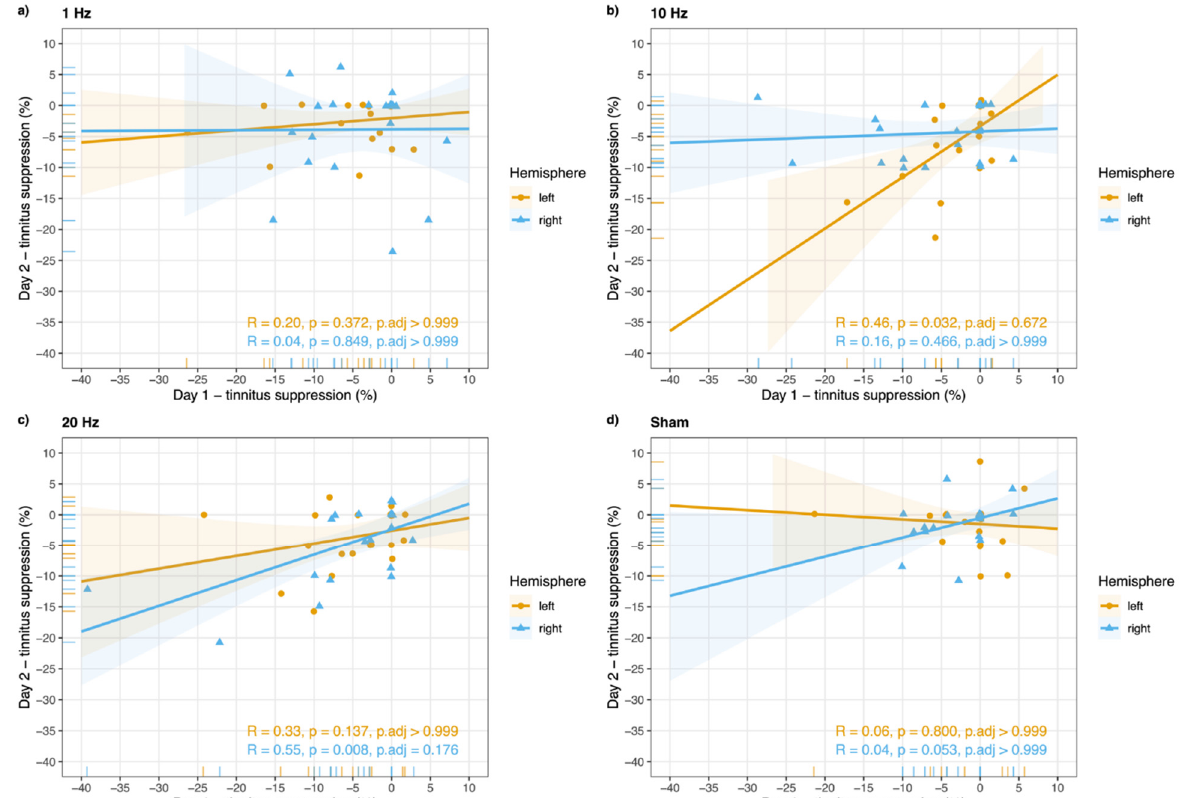
Figure 2. Reliability of TMS-induced changes in tinnitus loudness. Spearman correlations of rated tinnitus suppression (%) per rTMS protocol (1 Hz ( a ), 10 Hz ( b ), 20 Hz ( c ), sham ( d )) between the first and the second test session days are illustrated in Figure 2. Colored ribbons represent confidence intervals (95%). Reliable changes were observed for a ( b ) 10 Hz stimulation over the left temporo-parietal junction and a ( c ) 20 Hz stimulation over the right temporo-parietal junction. Both correlations do not withstand a correction for multiple comparison and should therefore not be overrated and interpreted only